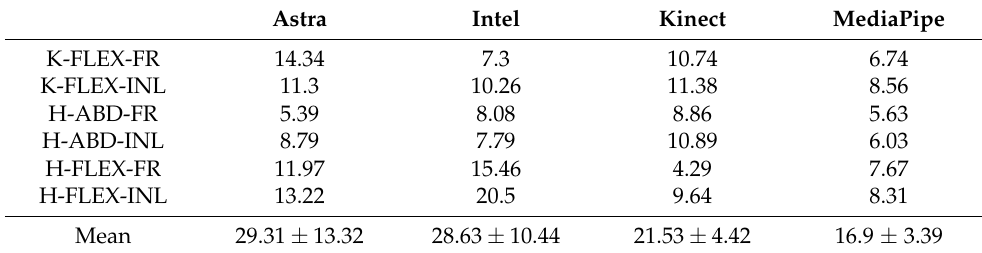
Table 8. Absolute error RMS values and mean for lower limbs in degrees ( ◦ ). Astra Intel Kinect MediaPipe K-FLEX-FR 14.34